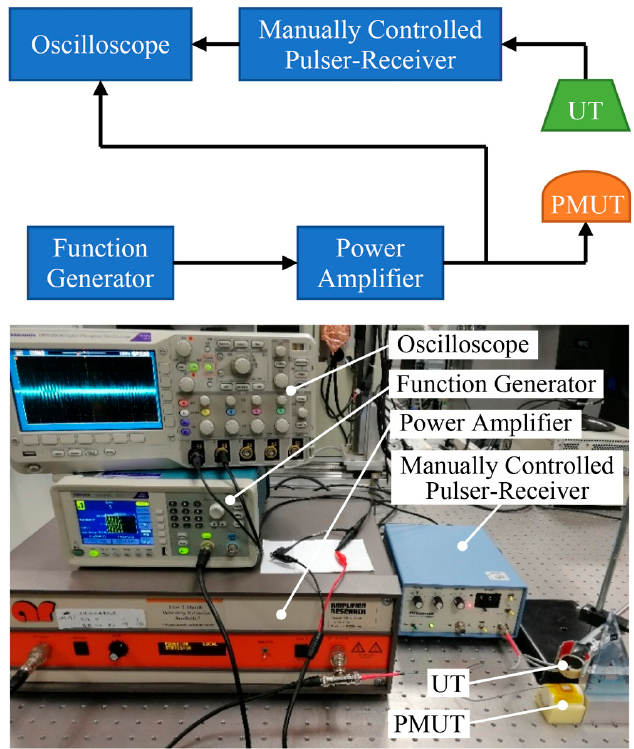
Figure 16. Acoustic transmit-receive system.